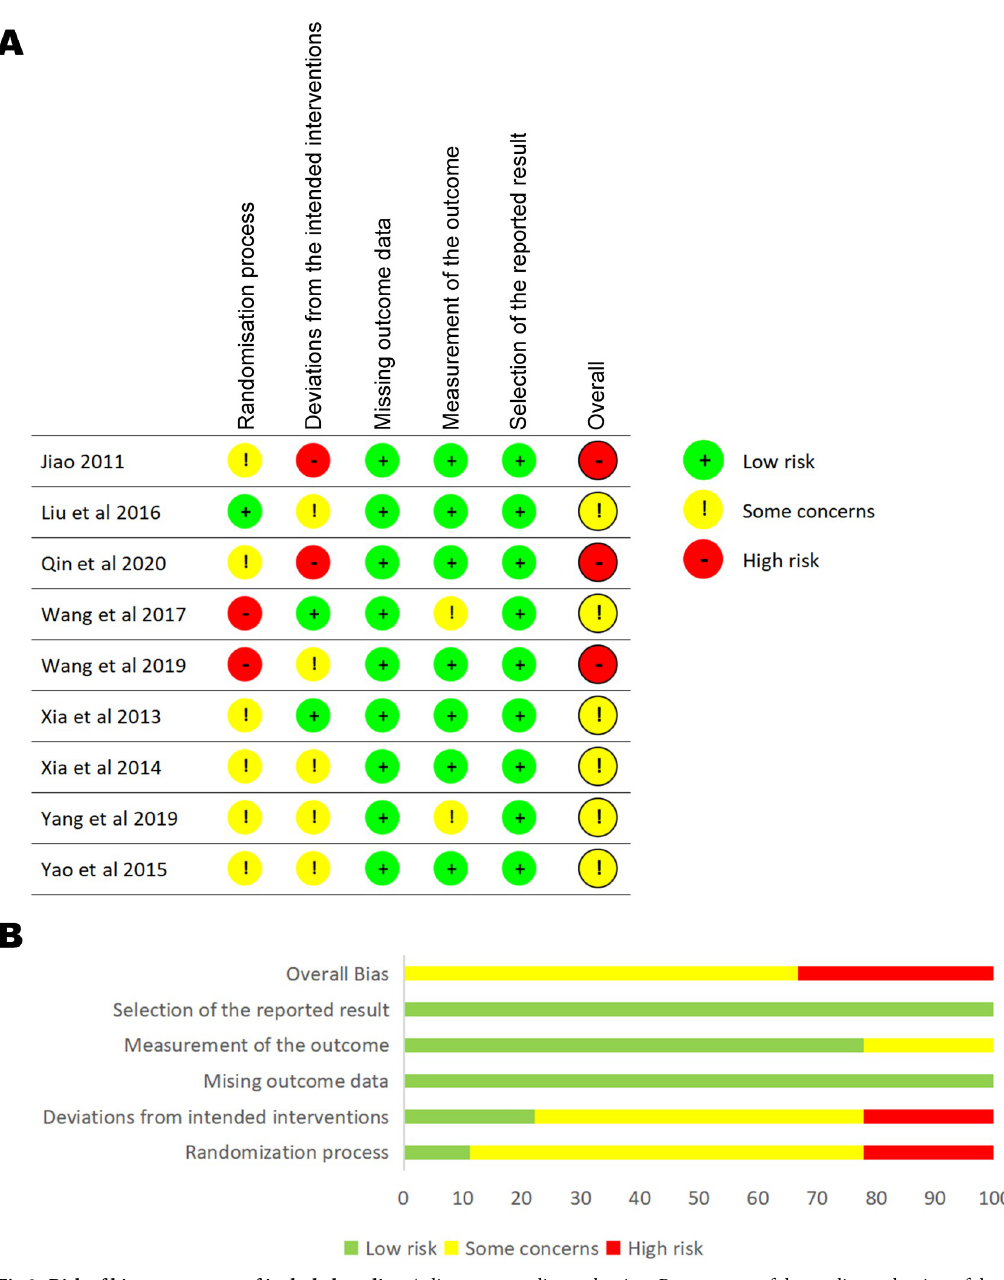
Fig 2. Risk of bias assessment of included studies. A, literature quality evaluation; B, summary of the quality evaluation of the